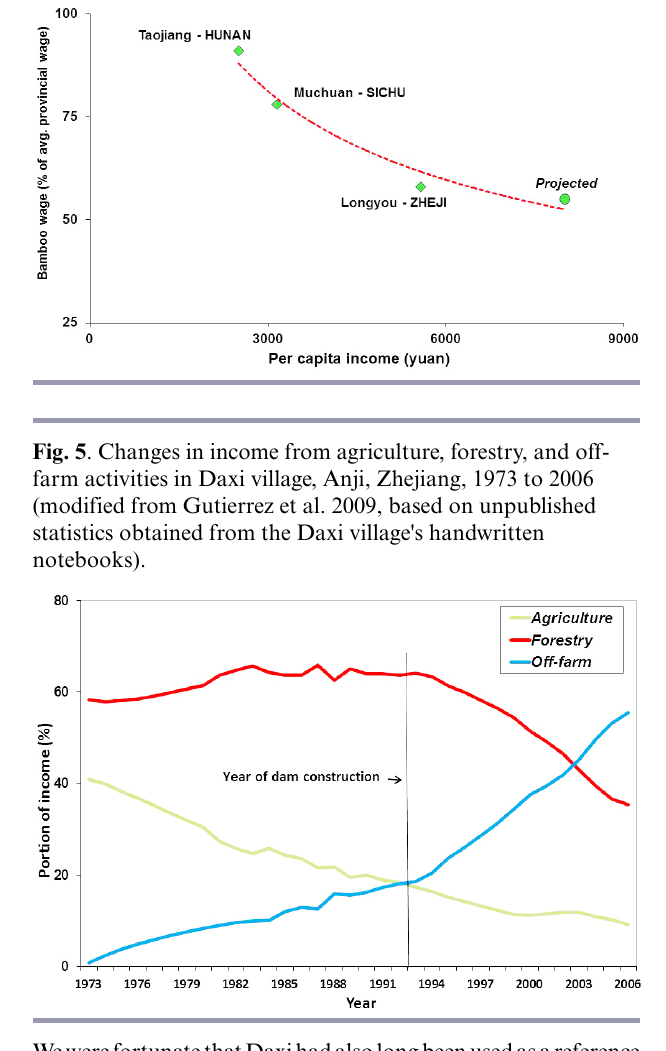
Fig. 4 . Ratio of bamboo industry to average provincial industry wages, in relation to the county’s per capita income (modified from Ruiz Perez et al. 2004).